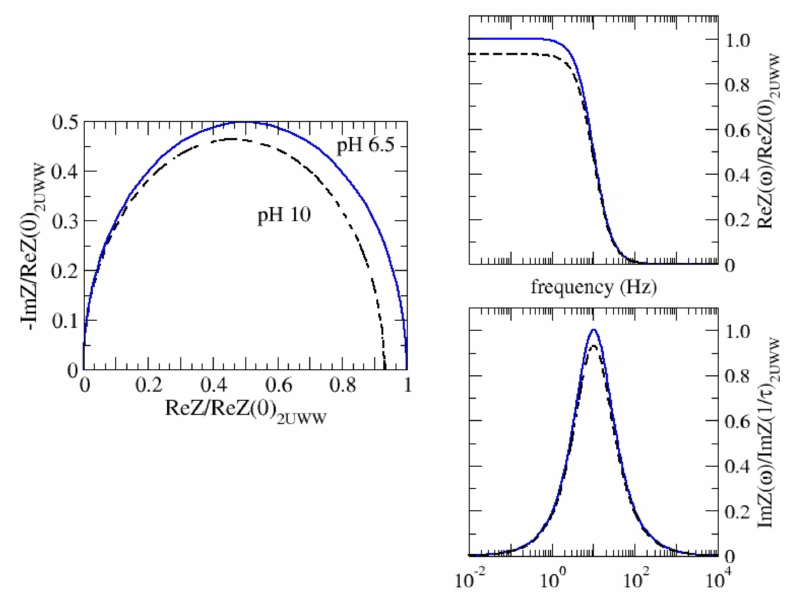
Figure 5. Nyquist (on the left) and Bode (on the right) plots of the b RC normalized impedance. Calculations refer to the single protein in the up-down orientation in dark, with pH = 6.5 (continuous line) and pH = 10 (dashed line). Calculations have been performed using ρ = 2.7 × 10 12 Ω Å and D = 10.5